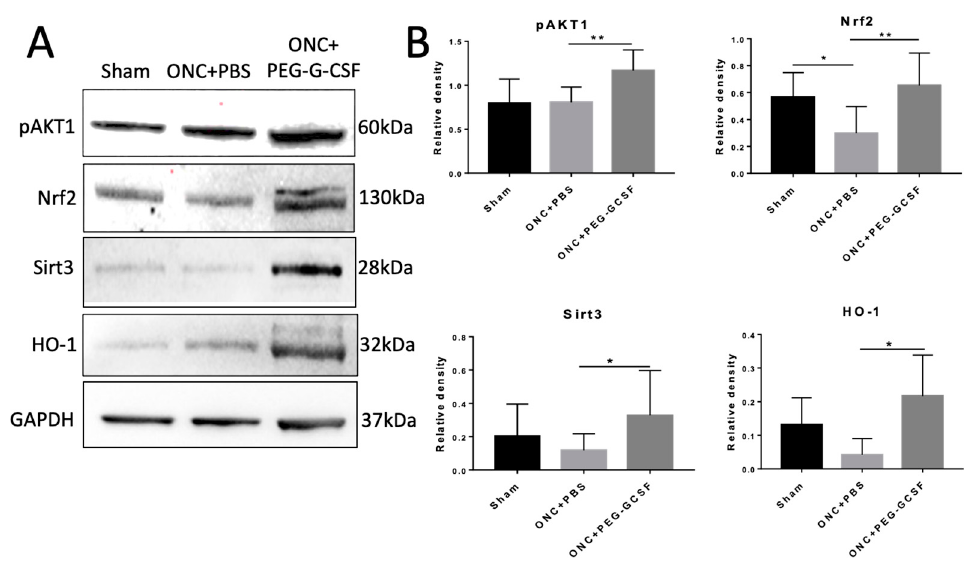
Figure 8. Western blot analyses in the samples of rat optic nerve (ON) post different operations. ( A ) Representative photograph of the immunoblotting of the expression of p-Akt1, Nrf2, Sirt3, and HO-1 in the ON samples. ( B ) Quantification of the protein bands of p-Akt1, Nrf2, Sirt3, and HO-1. Each value was measured by using iBright imaging software and normalized to GAPDH. The expressions of p-Akt1, Nrf2, Sirt3, and HO-1 were significantly higher in the PEG-G-CSF-treated crushed samples than those in the sham group or the PBS-treated crushed samples. Data are expressed as mean ± standard deviation (SD) in each group (n = 6 in each group). *: p < 0.05. **: p < 0.01.